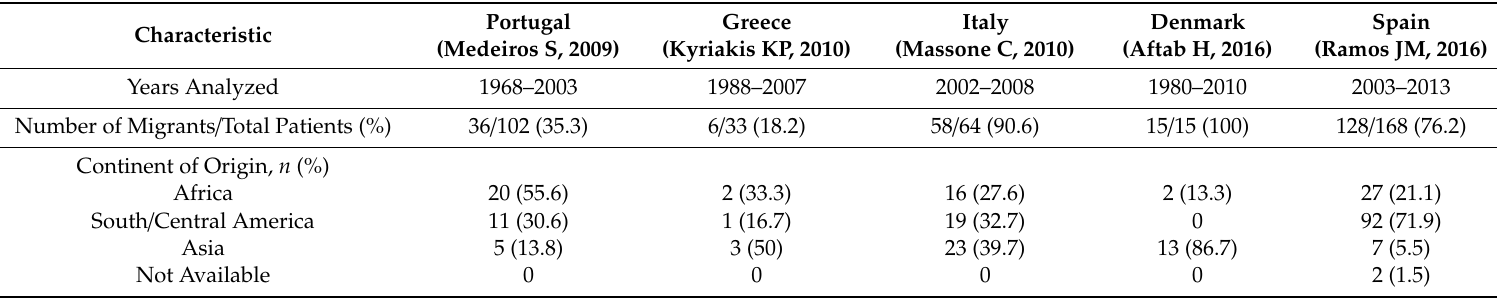
Table 2. Epidemiologic characteristics of 243 migrants diagnosed with leprosy described in five national reports from 2009 to 2018.